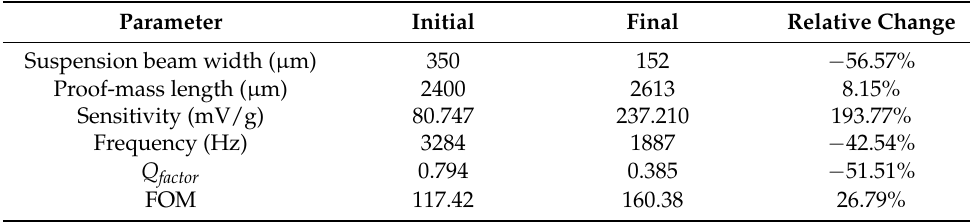
Table 2. Geometric and performance of initial and final accelerometer.